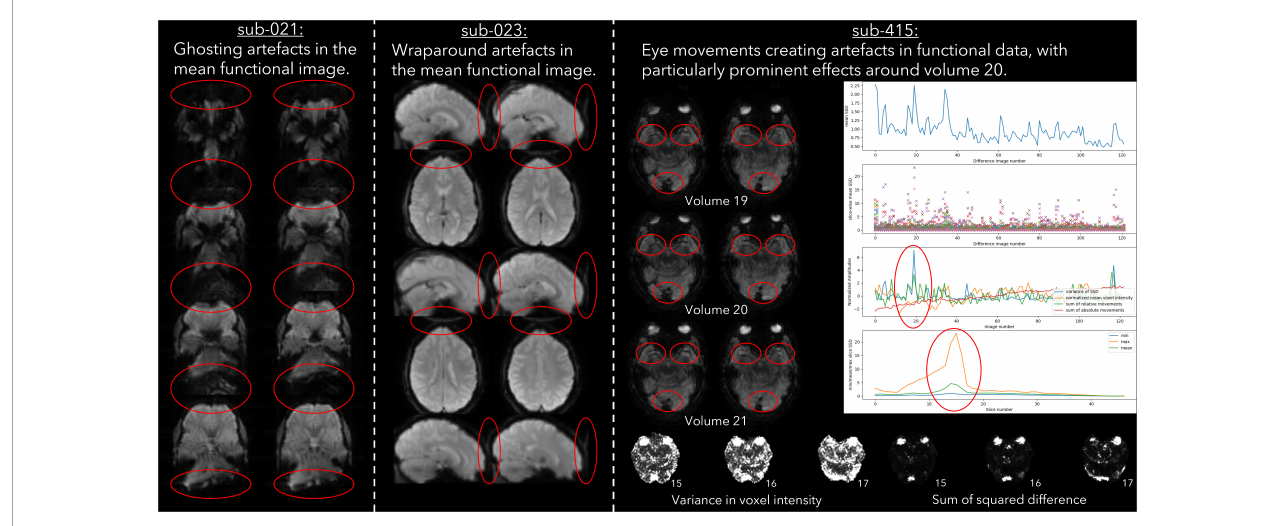
FIGURE2 Example cases of three different types of data acquisition artefacts detected using output from